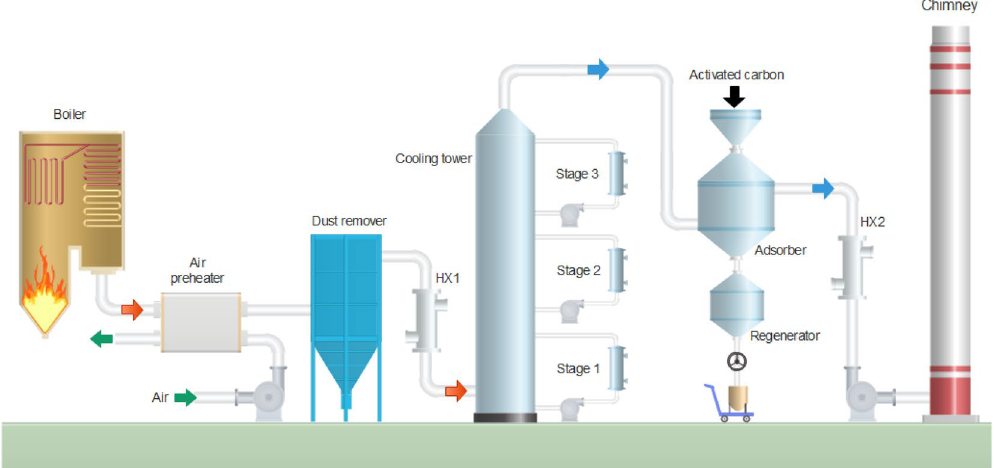
Figure 4. Schematic flowchart of pilot-scale test